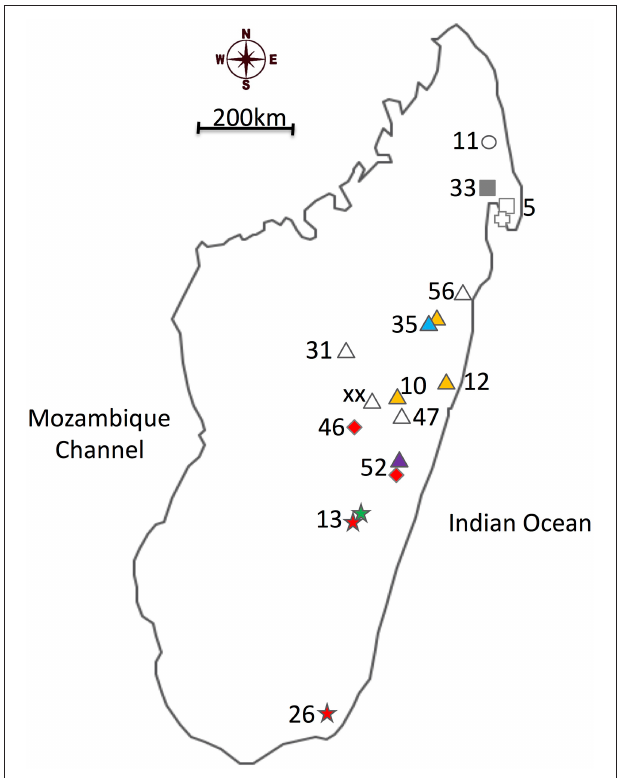
FIGURE 1 | Map of the different sites where the Nanos beetles were collected colored according to the main Wolbachia strain infection. Collection sites are labeled as described in Table 1 . Shapes are specific to host species, while colors inform on the Wolbachia infection status of the samples. (Cross): Nanos nitens , (Square): N. clypeatus, (Circle): N. mirjae, (Triangle): N. dubitatus, (Diamond): N. pseudoviettei, and (Star): N. viettei . (Yellow): strain A, (Red): strain B, (Green): strain C, (Blue): strain D, (Gray): strain E, and (White):